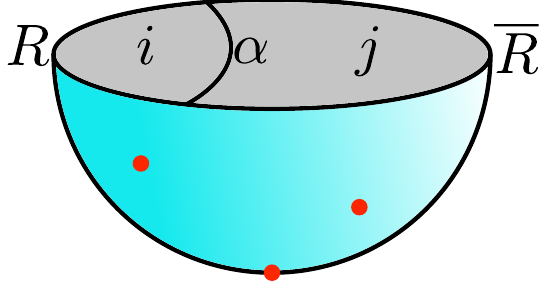
Figure 2 . Using the bulk Euclidean path integral to prepare a state. The red dots are boundary sources we can adjust to change which state we prepare, and the center degrees of freedom (cid:11) are the induced metric data on the HRT surface (cid:13) R